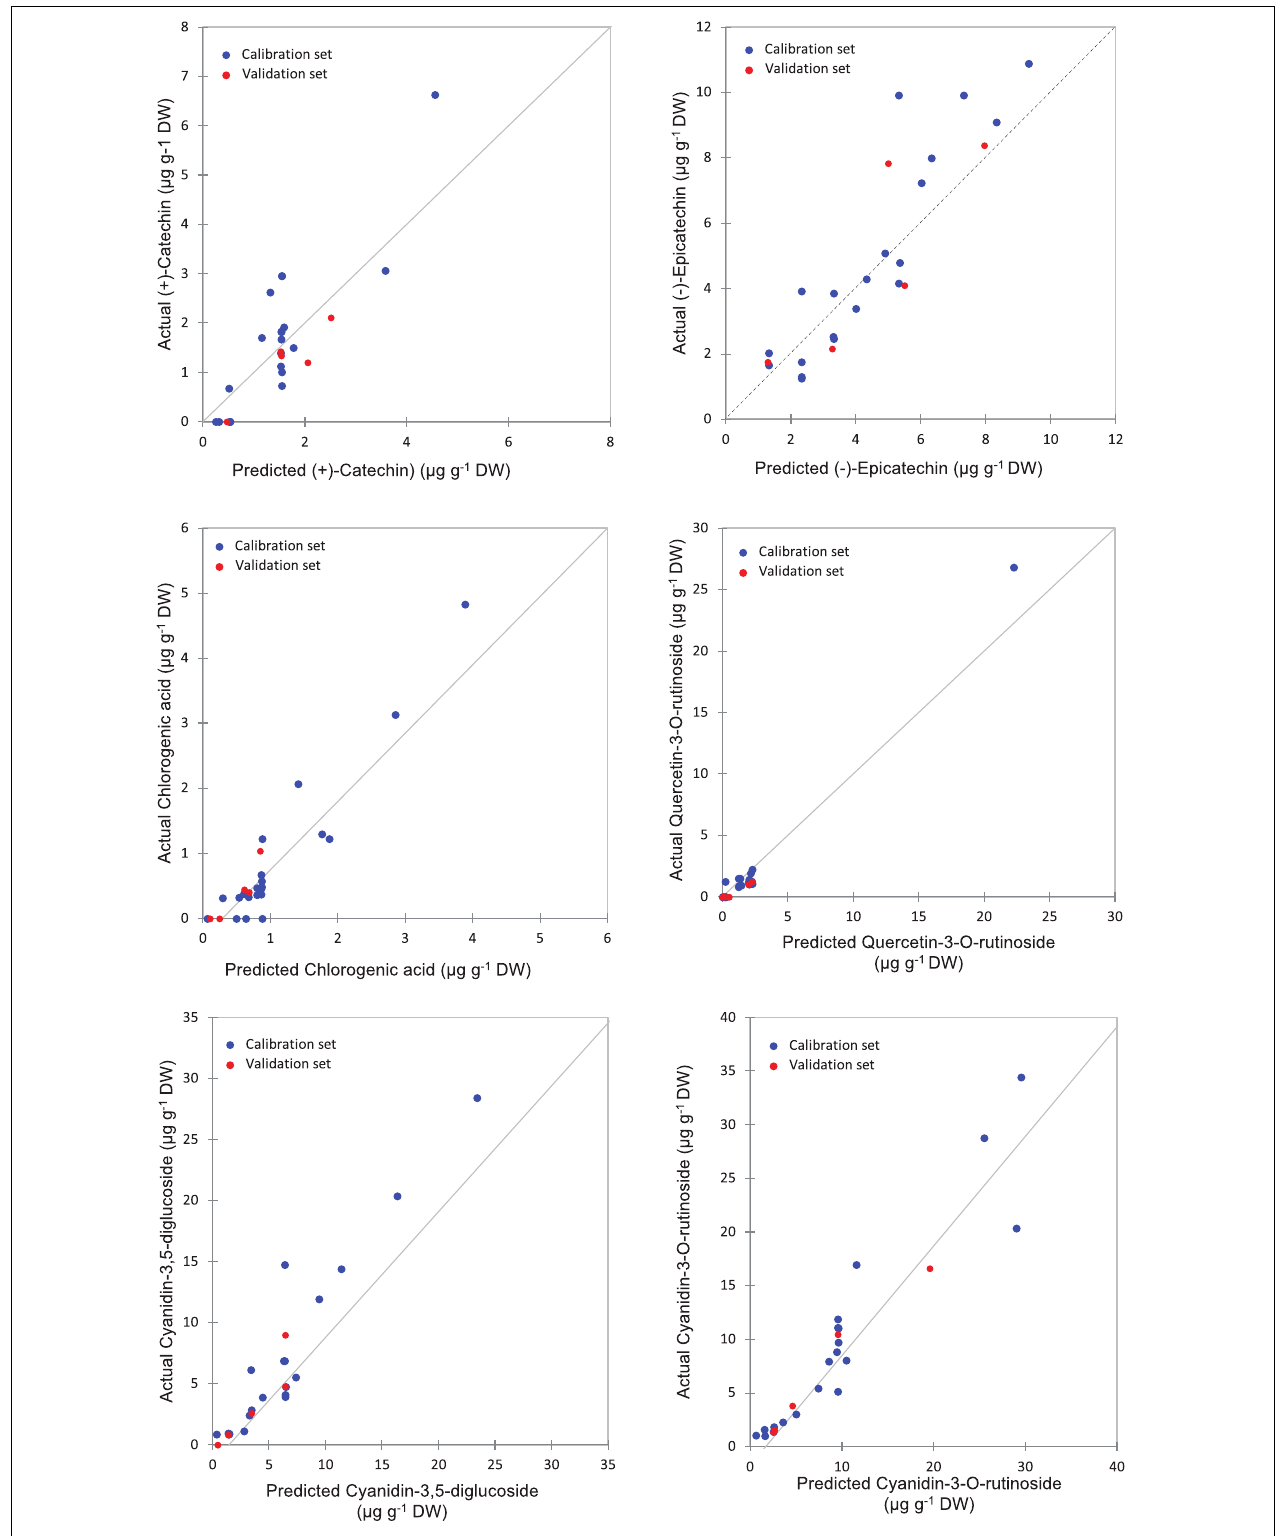
FIGURE 6 | Correlation plots for the prediction of phenolic compounds in the pulp samples using PLSR based on the FT-IR spectra.